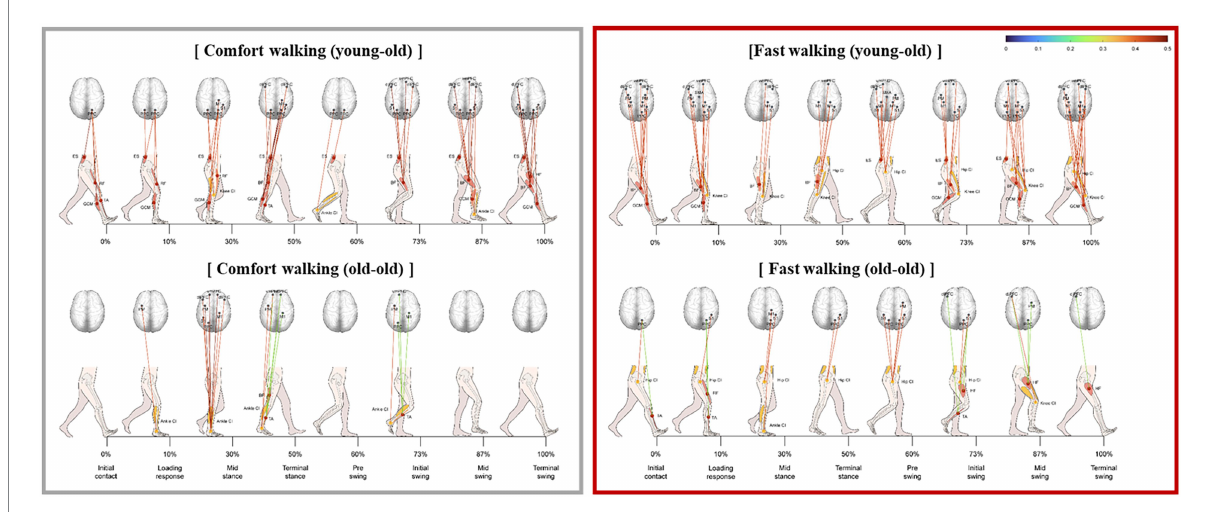
FIGURE 4 Significant correlation between lower limb muscle activity and cortical activation during fast walking in the young-old and old-old groups.